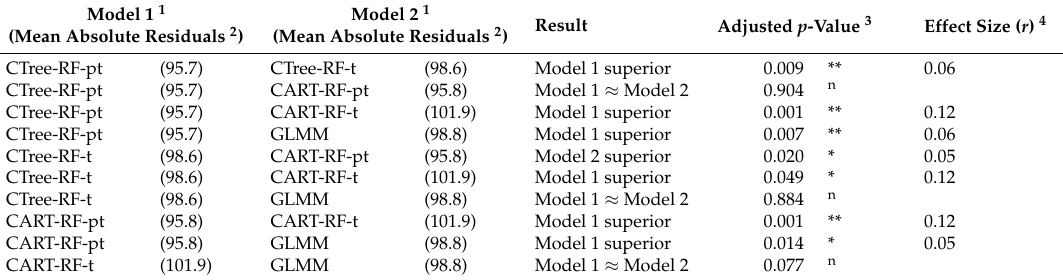
Table 2. Testing models for statistically significant differences with reference to absolute residuals of plot-level harvested volume predictions with the paired sample t-test. Null hypothesis: The averages of the residuals of model 1 and model 2 do not differ (RF: random forest; CTree-RF: RF based on conditional inference trees; CART-RF: RF based on classification and regression trees; GLMM: generalized linear mixed model).